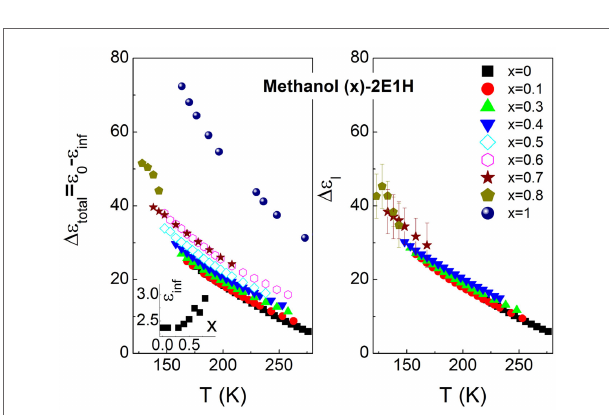
1-haxanol (2e1h) mixtures, showing increasing broadening of the slow relaxation . The data fitting show Cole–Cole equation explains the slow relaxation with higher fitting quality.